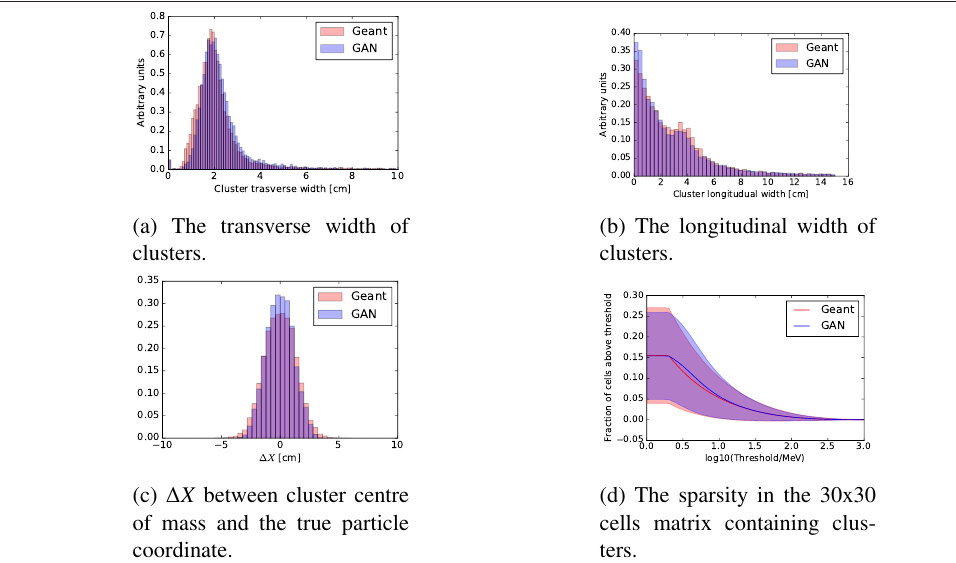
Figure 3: Comparing physics characteristics for Geant4 simulated (red) and generated (blue)